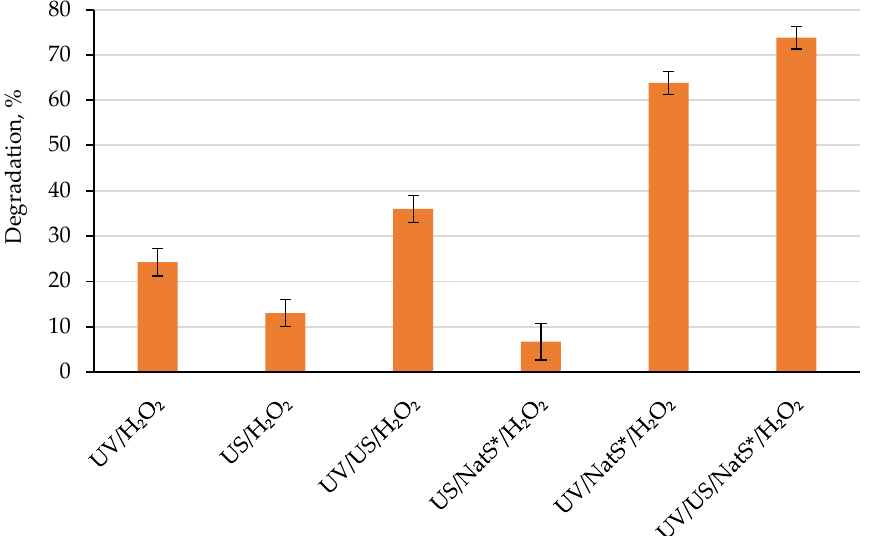
Figure 6. 4-chlorophenol degradation under UVA LED (365 nm) and/or ultrasonic (1.7 MHz) irradiation using calcined natural sphalerite (NatS*, 900 ◦ C, 1 g/L, 75 µ m sieve) in the presence of 1 mM H 2 O 2 . [4-CP] 0 = 10 mg/L, exposure time = 1 h. It is notable that the contribution of NatS* was ~2-fold higher than that of H 2 O 2 (46 vs. 24%). However, simultaneous ultrasonic exposure did not significantly enhance the degradation in the system UV/US/NatS*/H 2 O 2 (74%). This is presumed to be due to the prevalent contribution of photo-based processes (UV/H 2 O 2 and UV/NatS*) as compared to sono-based processes. The hybrid UV/US/ZnO/H 2 O 2 process was also previously applied for degrading Reactive Yellow azo dye [30] and antibiotic ofloxacin [31]. Note that the analytical grade pure ZnO, low-frequency ultrasound (20, 40 kHz) and conventional UVC low-pressure mercury lamp (254 nm) were applied in these studies. Patidar and Srivastava (2021) [31] reported a high synergistic effect in the UV/US/ZnO/H 2 O 2 system with index of 3.10. Under our experimental conditions an additive effect was observed (index =